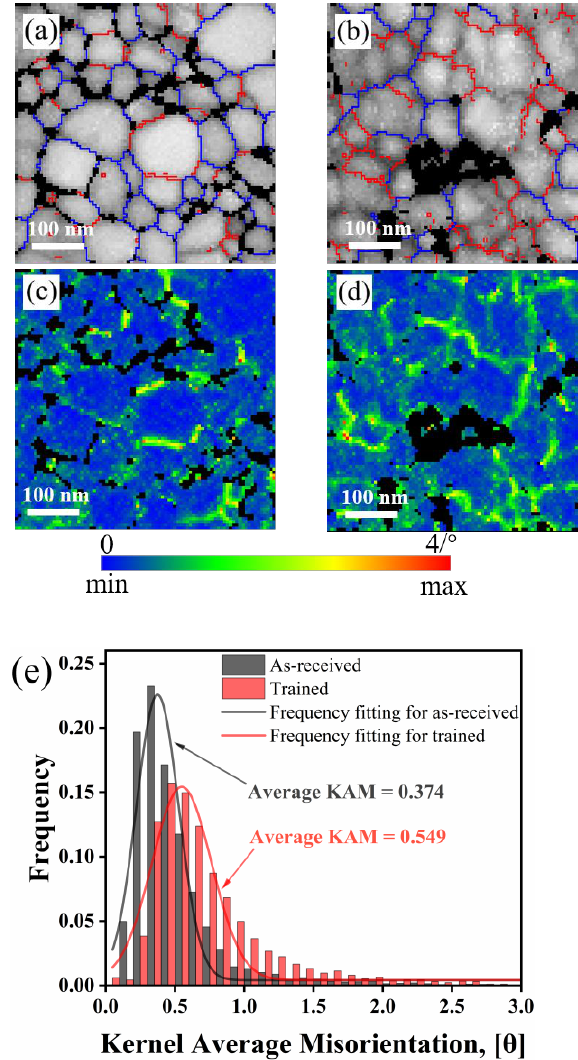
Figure 8. ( a , c ) show grain boundaries and kernel average misorientation (KAM) maps for the as- received sample, respectively. ( b , d ) are those for the trained sample. For (a) and (b), low-angle grain boundaries (LAGBs) are in red (2° < 𝛽 < 10°), and high-angle grain boundaries (HAGBs) are in blue ( 𝛽 > 10°). ( e ) shows the distribution of KAM values for both samples.